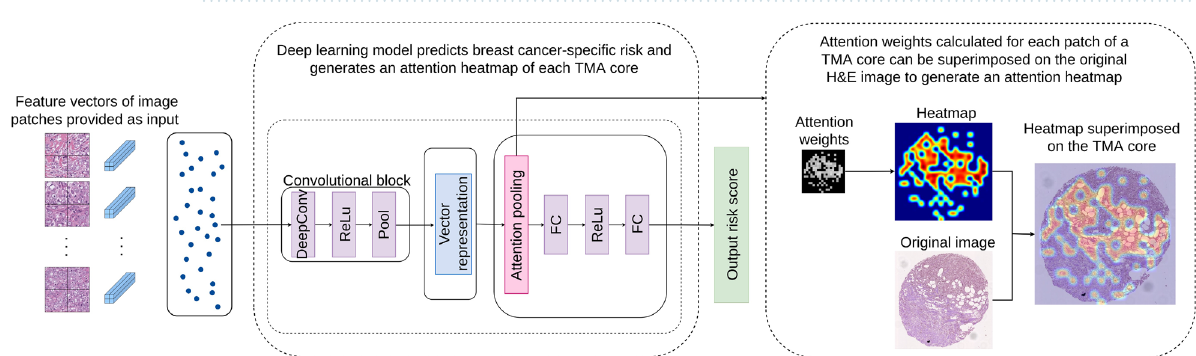
Figure 2. Architecture of the MIL-based survival risk prediction model using pretrained feature encodings (Model 1).